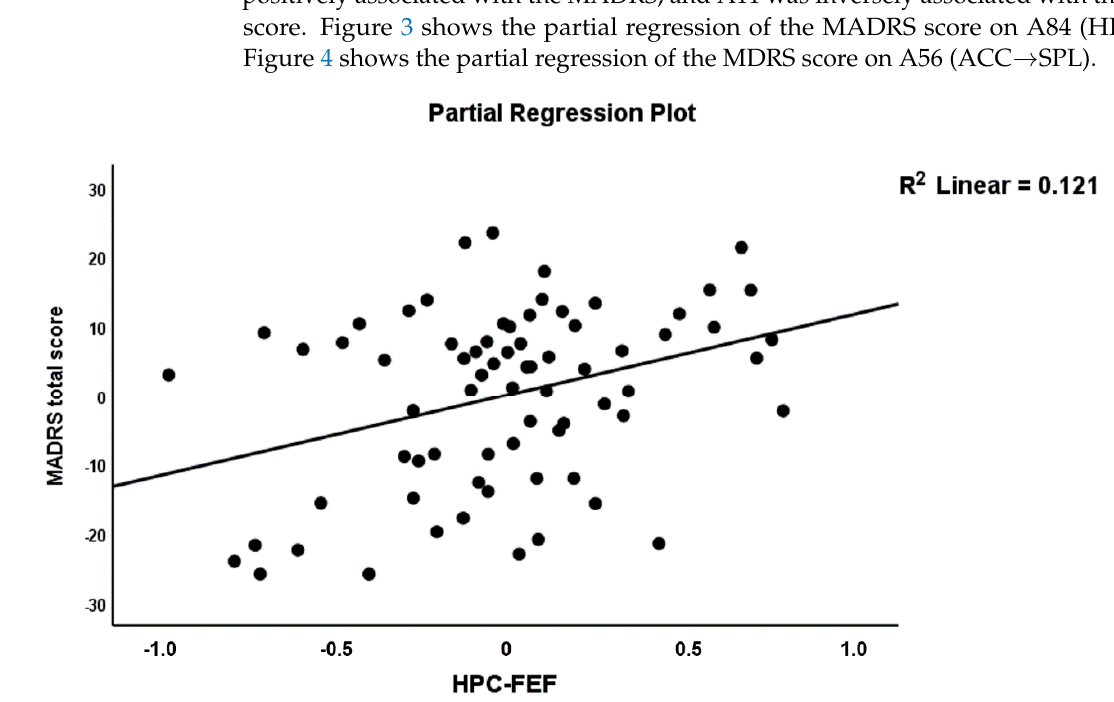
Figure 4. Partial regression plot of the MADRS score on the ACC → SPL connection. To examine the connectome features of OSOS, we first entered the two connectome variables that significantly discriminated SCZ from controls and found that A17 (posi- tively) and A76 (inversely) were significantly associated with OSOS explaining 26.9% of its variance. Entering the other connectome feature sets revealed that A76 was no longer significant after considering the effects of two other variables, namely A12 and A26, which were both inversely associated with OSOS. As such, three connectome features explained 40.6% of the variance in OSOS, namely A17 (positively), A12 and A26 (both inversely).